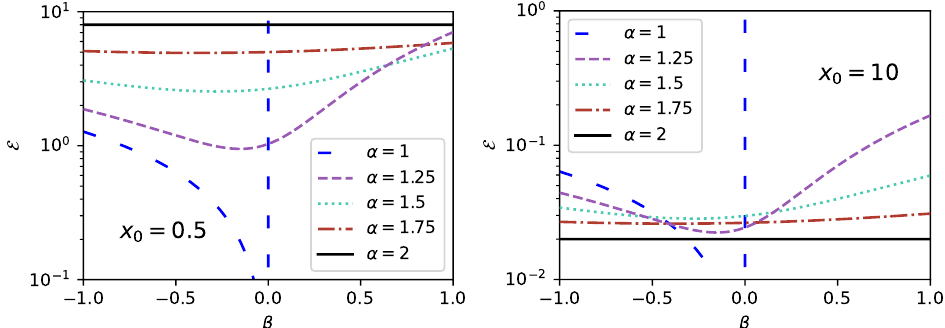
Figure 7. Search efficiency E as function of the skewness parameter β for different values of α with K α = 1 in log-linear scale.